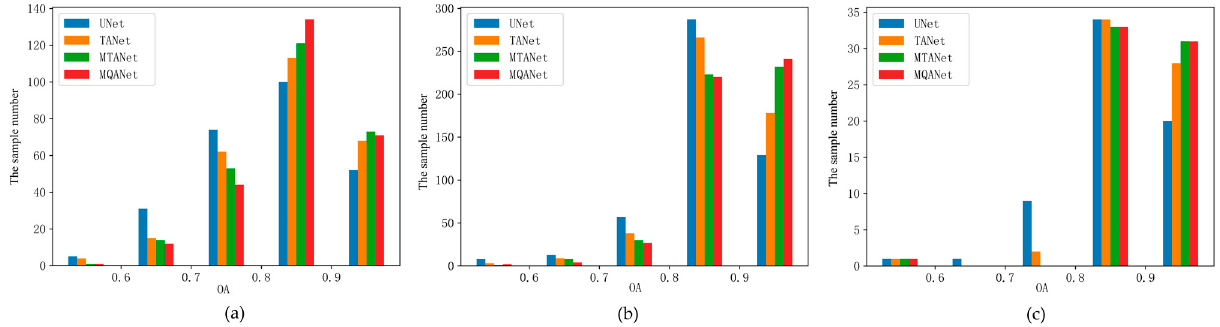
Figure 15. OA distribution of different models results in three datasets. ( a ) OA distribution map on CZ-WZ data set, ( b ) OA distribution map on Potsdam data set, ( c ) OA distribution map on Vaihingen data set.